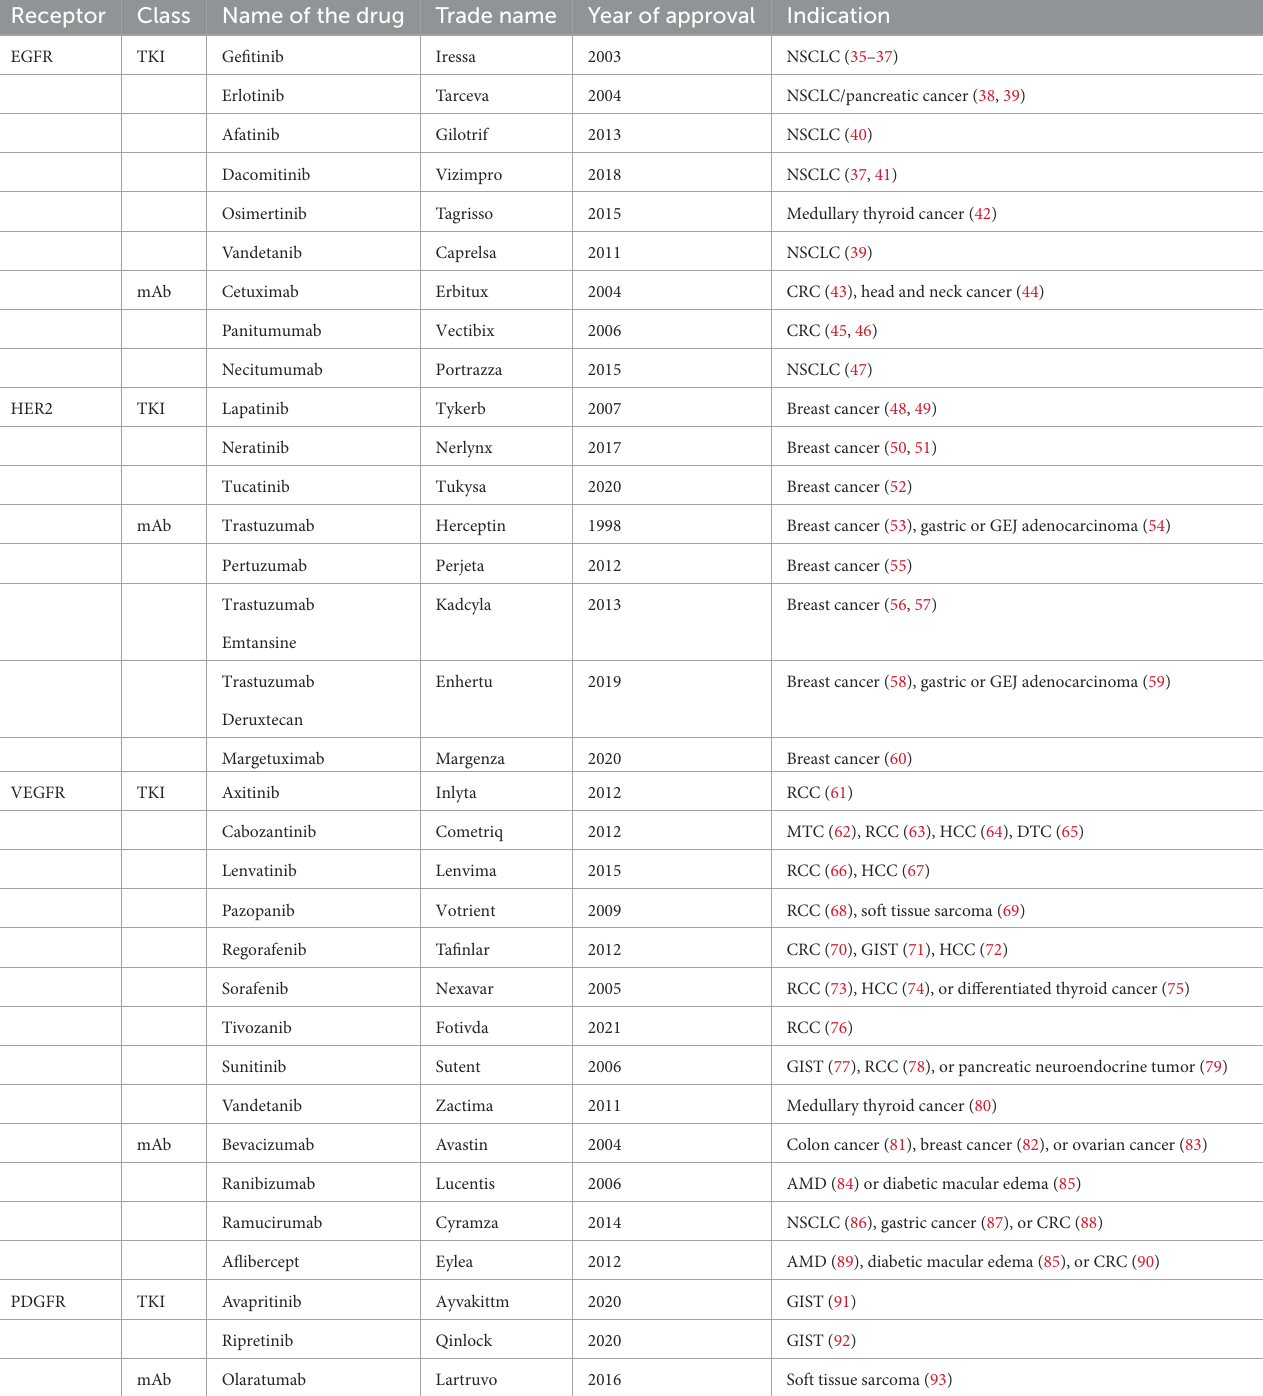
TABLE 1 TKIs approved by FDA in cancer treatment.